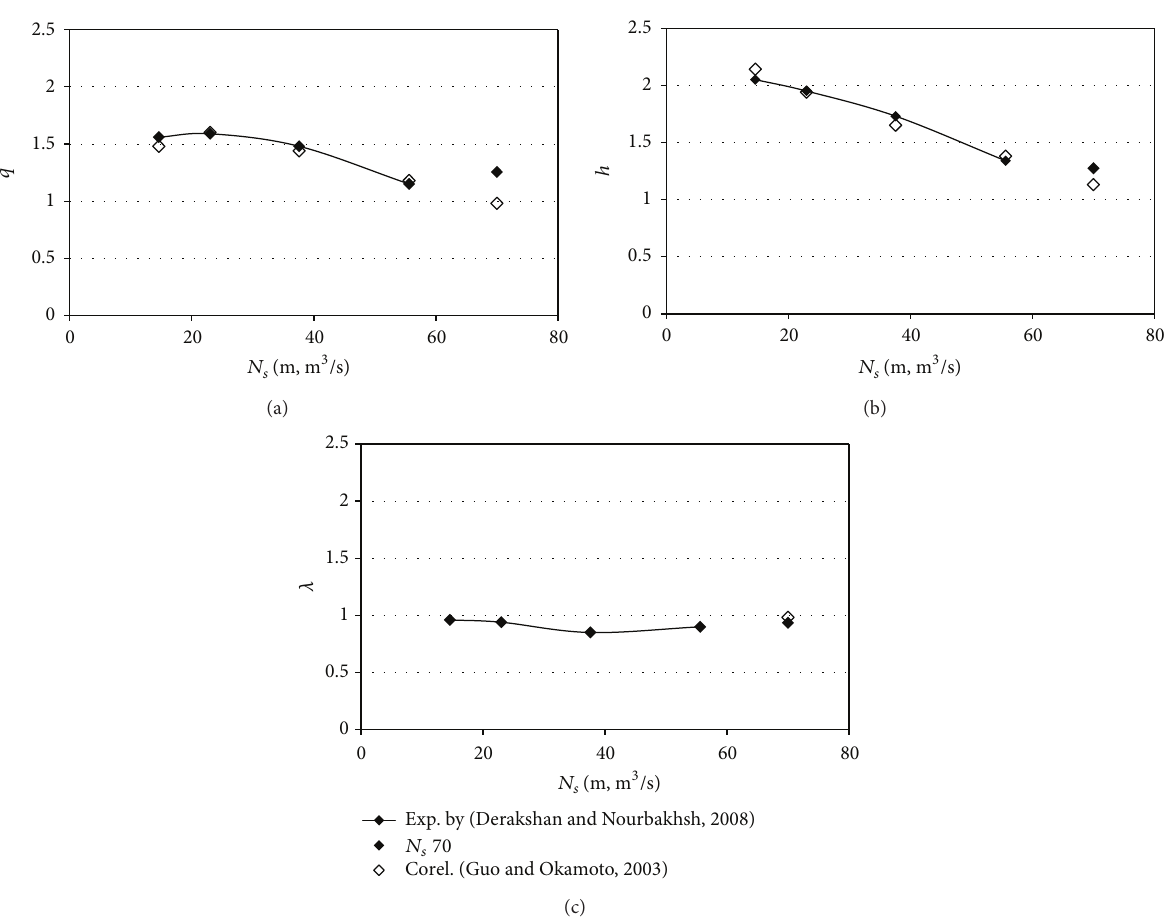
Figure 5: Dimensionless BEP characteristics of PATS—experiments by Derakhshan and Nourbakhsh [14] and tested pump.